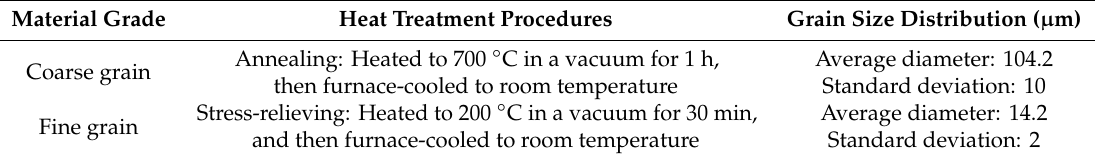
Table 2. Heat treatment procedures and grain size